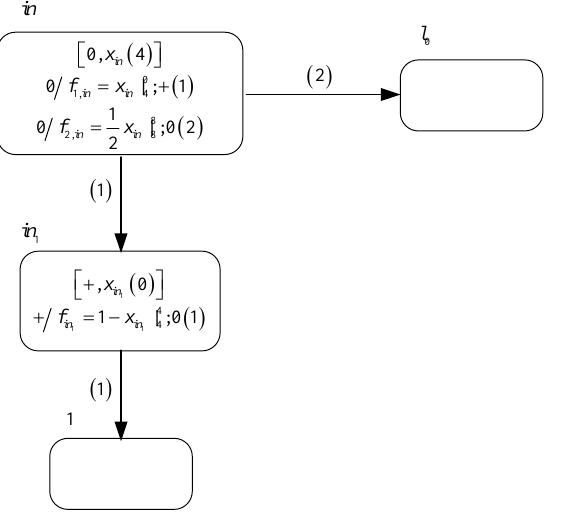
Figure 6. The INPUT module in system Π